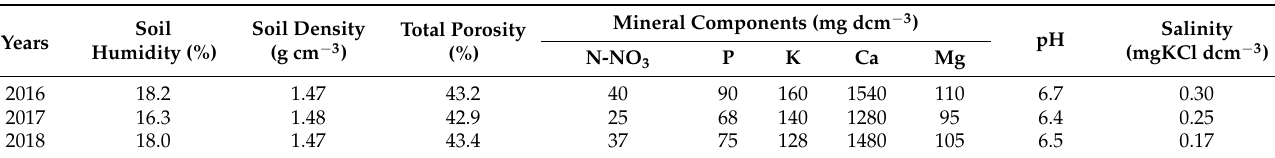
Table 1. Physical and chemical characteristics of a soil with bell pepper grown with or without mycorrhizal inoculation and